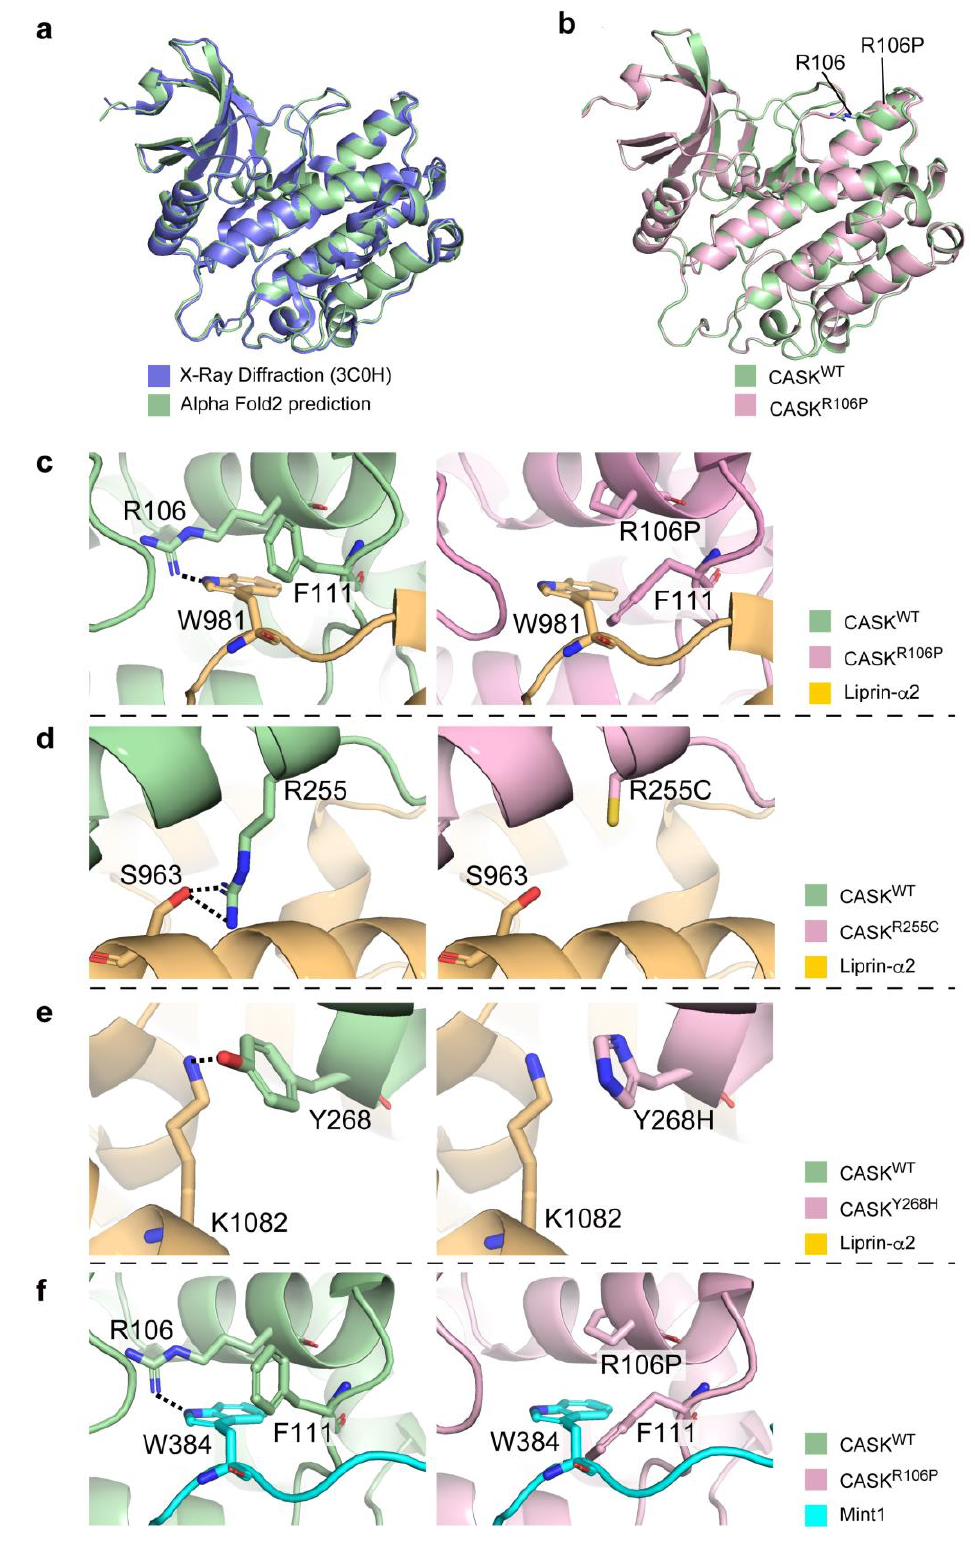
Figure 7. Deleterious mutations disrupt the binding interface between CASK-CaMK and Liprin-α2 predicted by AlphaFold 2.2 (DeepMind, London, UK). ( a ) Superimposed image of the 3D structure of the CASK-CaMK domain modeled by X-ray crystallography data (purple, 3C0H) and Al- phaFold2.2 from the amino acid sequence (green). The AlphaFold2.2 predicted model perfectly overlaps with the X-ray crystallography. ( b ) Superimposed image of the wild-type (green) and R106P mutant (pink) CASK-CaMK domain modeled by AlphaFold2.2. The R106P mutation does